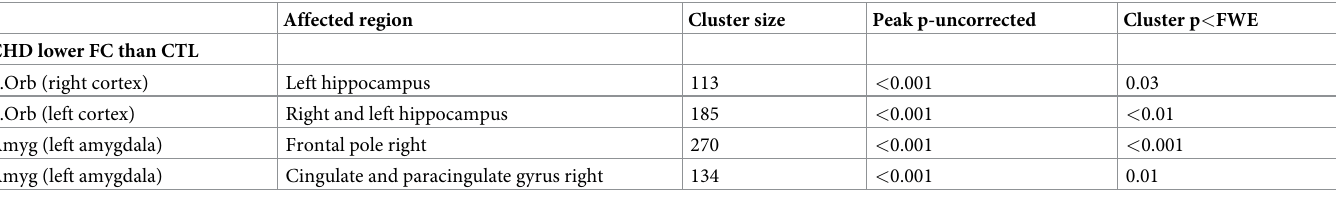
Table 3. Functional connectivity differences between CHD and control groups where CHD participants presented with lower functional connectivity than controls. Affected region Cluster size Peak p-uncorrected Cluster p < FWE CHD lower FC than CTL F.Orb (right cortex) Left hippocampus 113 < 0.001 0.03 Right and left hippocampus Frontal pole